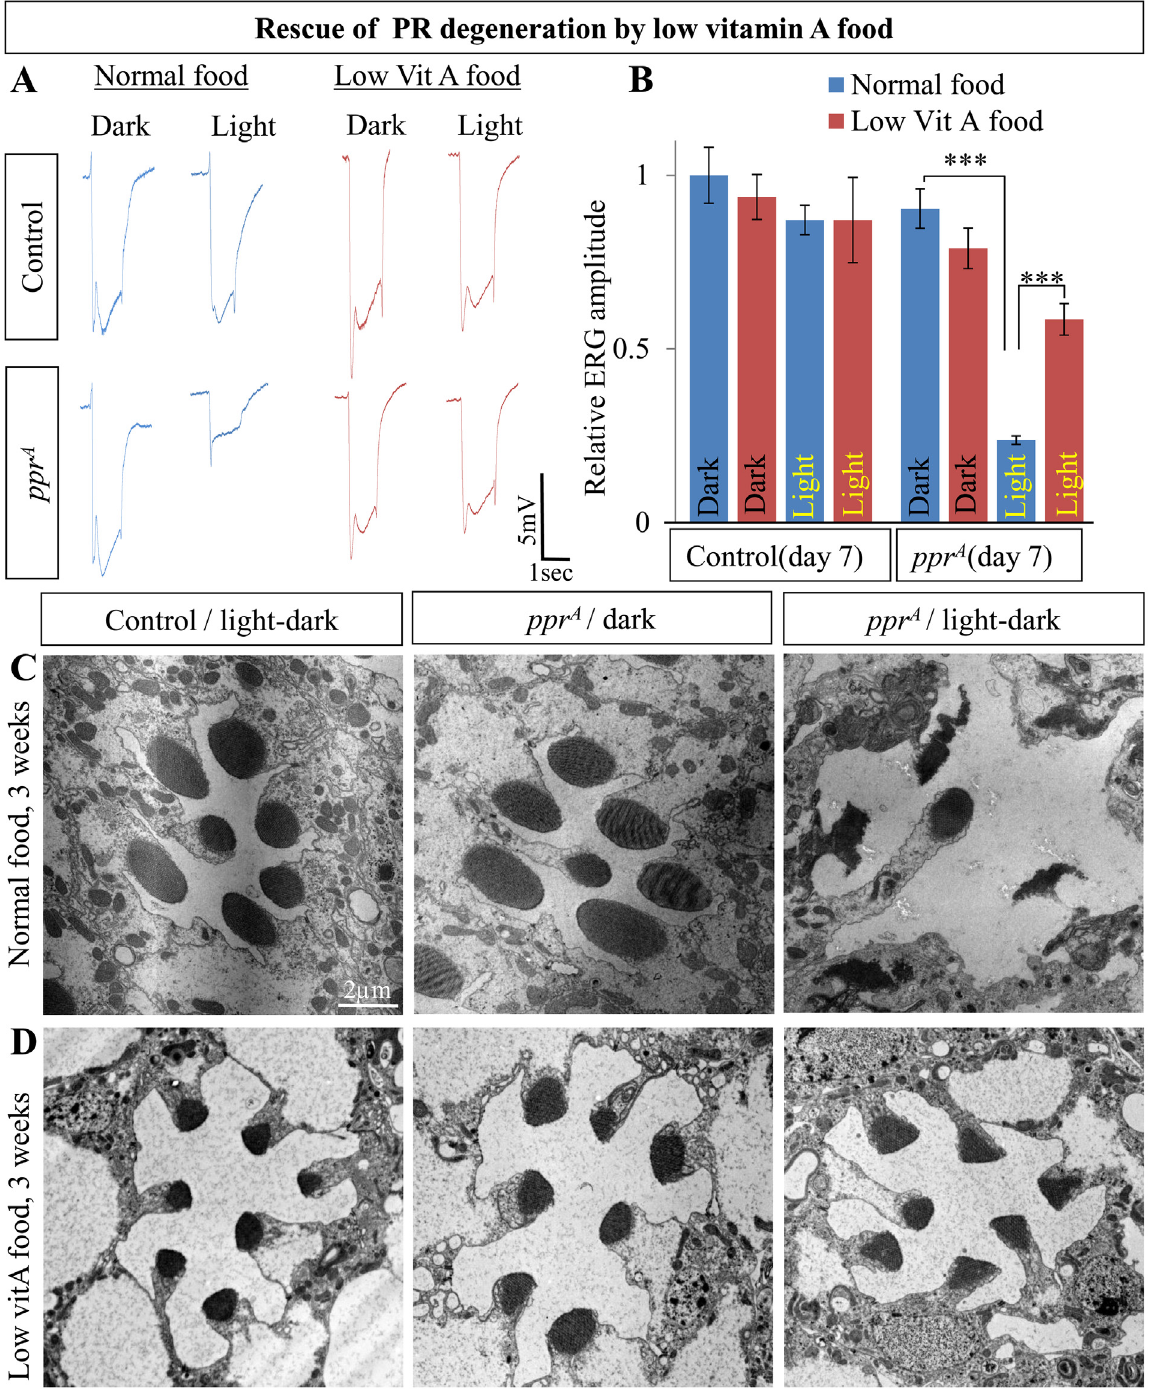
Fig 5. Rh1-dependent degeneration of ppr mutant PRs. (A) ERG traces from control (top) or ppr A (bottom) eye clones. Flies were raised on normal food (blue, left) or low vitamin A food (red, right) and kept in the dark or constant light for seven days. (B) Quantification of relative ERG amplitude from the experiment shown in A. Error bars represent ± SEM; two-tailed Student's t test ( p -value *** < 0.001). (C, D) TEM of control and ppr A ommatidia. Flies were raised on normal food (C) or low vitamin A food (D) and raised in the dark (middle, ppr A ) or 12 h light/dark cycle (left, control and right, ppr A ) for three weeks.